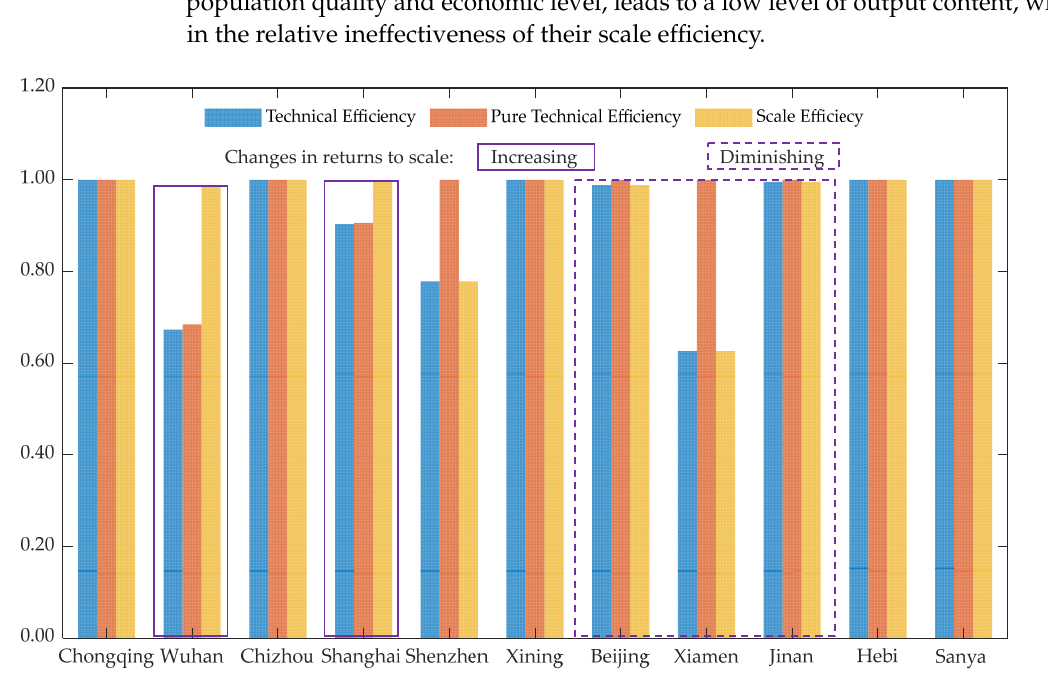
Figure 2. The efficiency of DMUs.